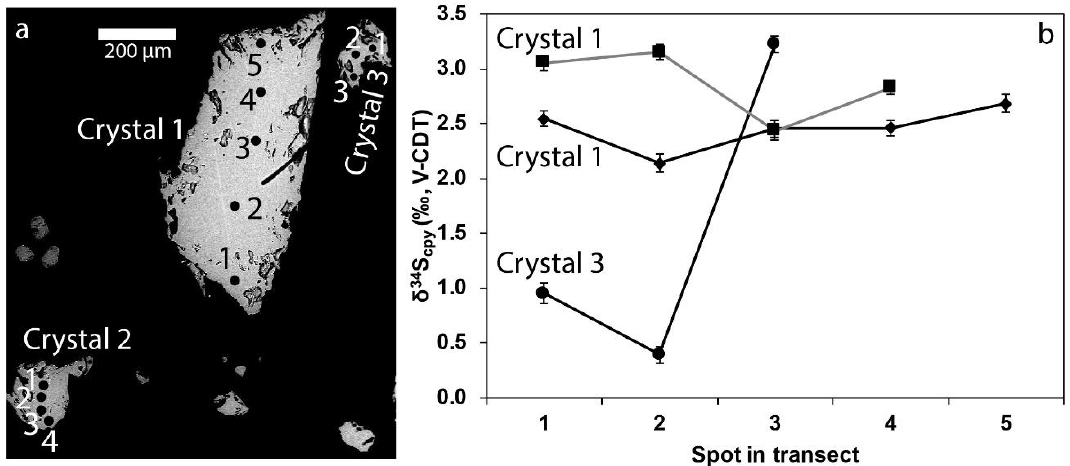
Figure 3. Transects of δ 34 S values in polished chalcopyrite crystals. ( a ) BSE image with analytical spots marked. ( b ) δ 34 S values of three crystals.